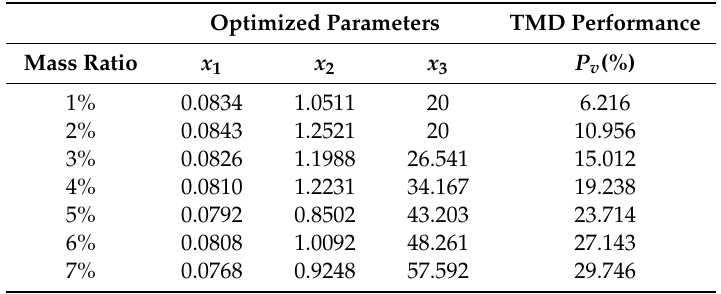
Table 4. Optimized parameters and TMD performance for various mass